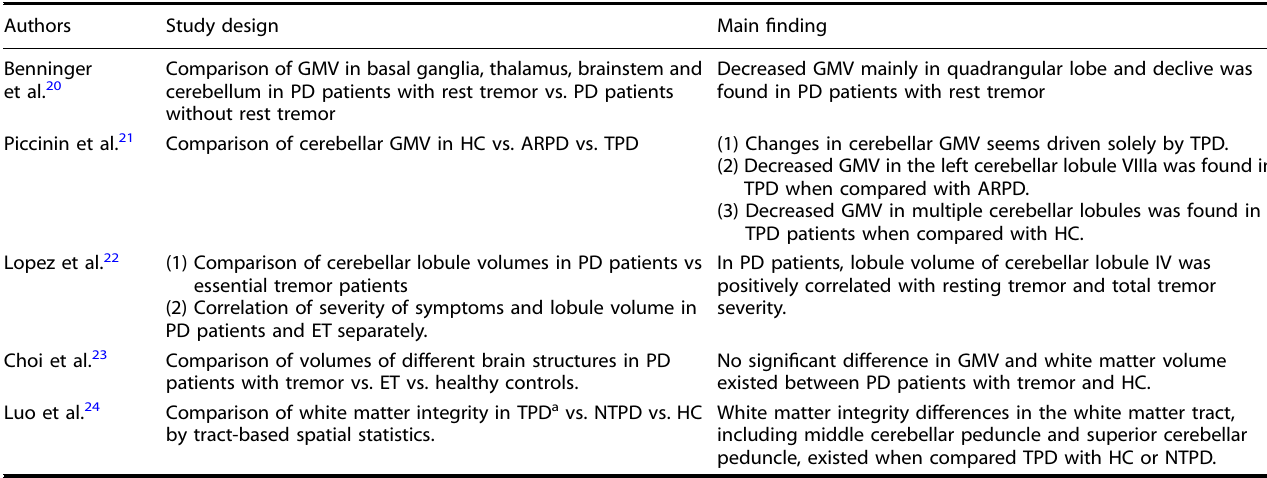
Table 1. Structural imaging studies reporting on tremor and cerebellum in Parkinson ’ s